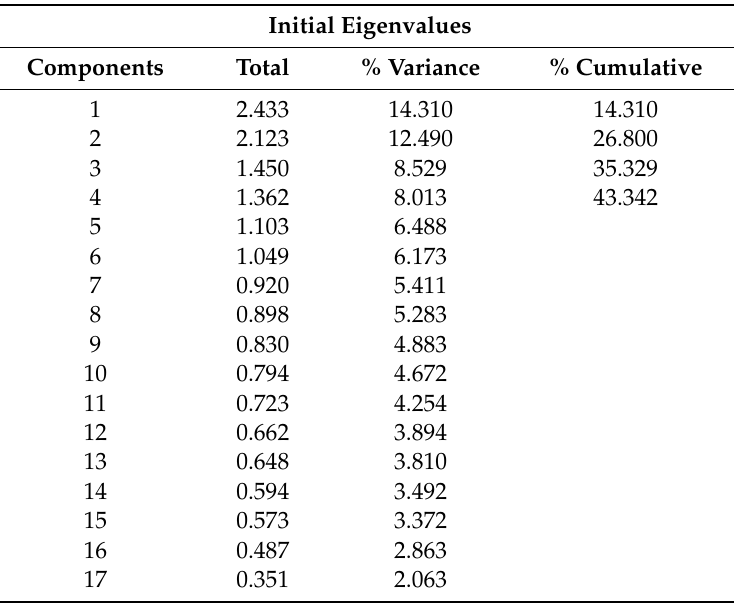
Table 3. Eigenvalues of extracted components.